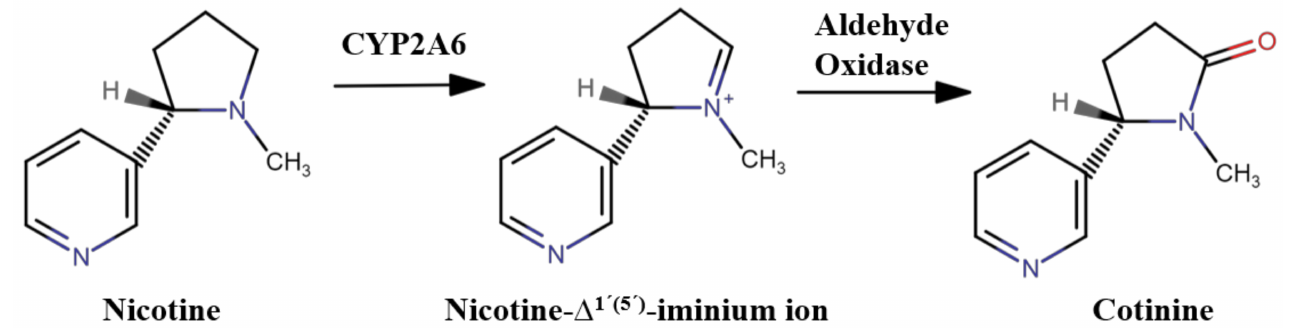
Figure 1. Chemical transition of nicotine to cotinine by